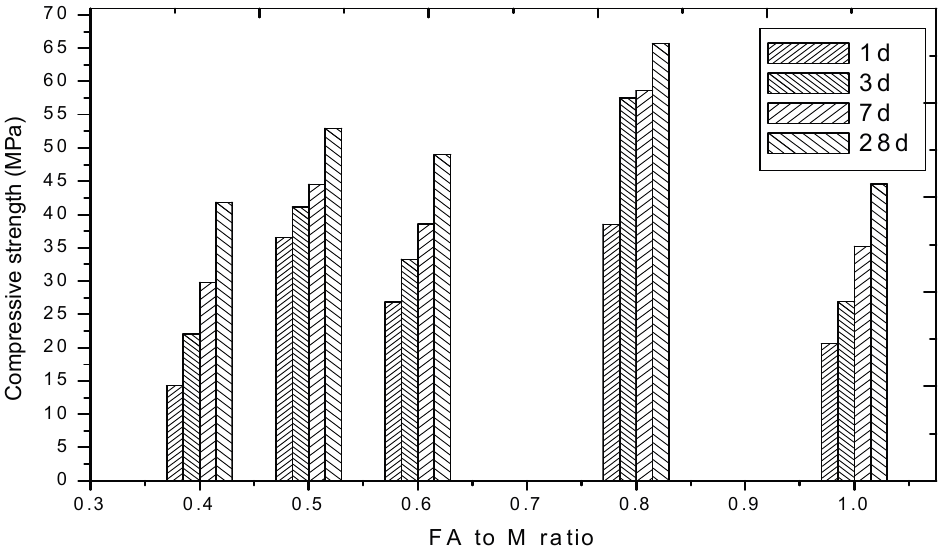
Figure 6. The effect of FA content on the compressive strength of MPC paste.